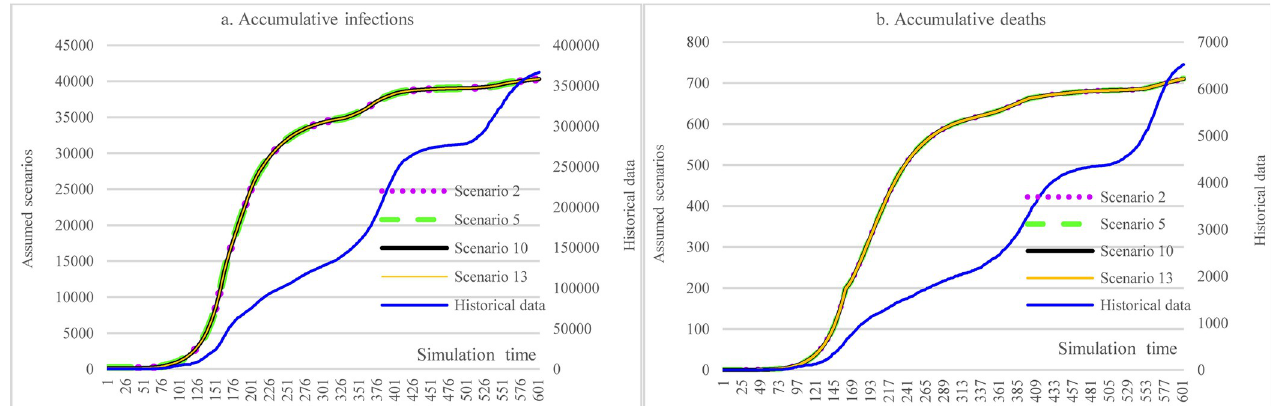
Fig 5. Impacts of enforced social distancing for social events in counterfactual analysis.